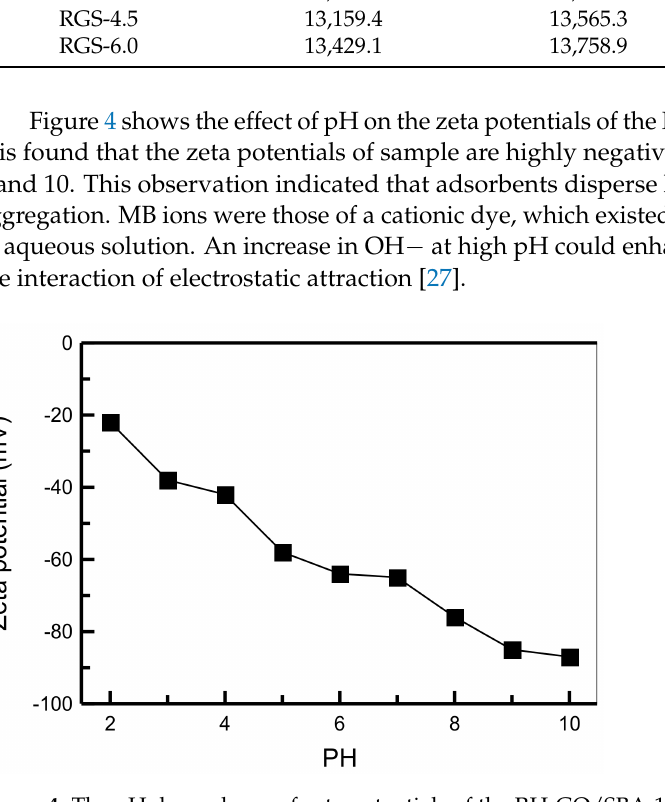
Figure 4. The pH dependence of zeta potentials of the